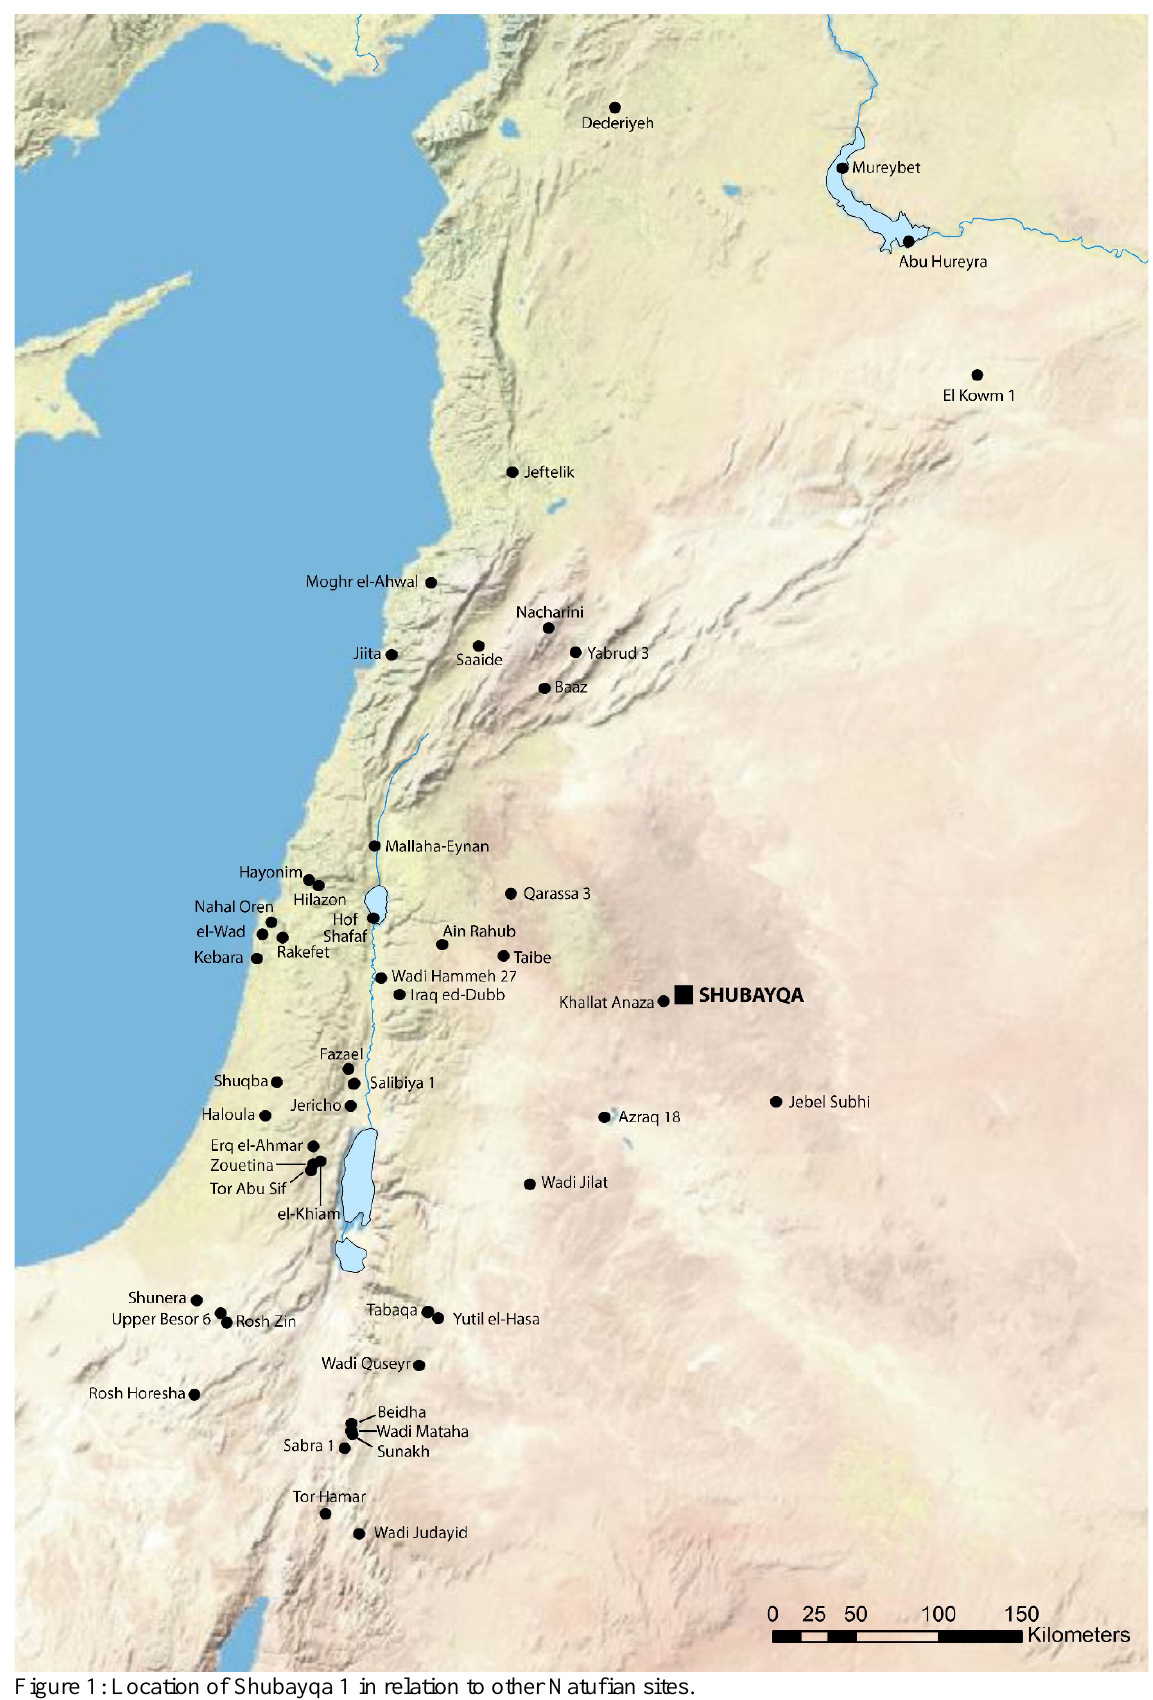
Figure 1: Location of Shubayqa 1 in relation to other Natufian